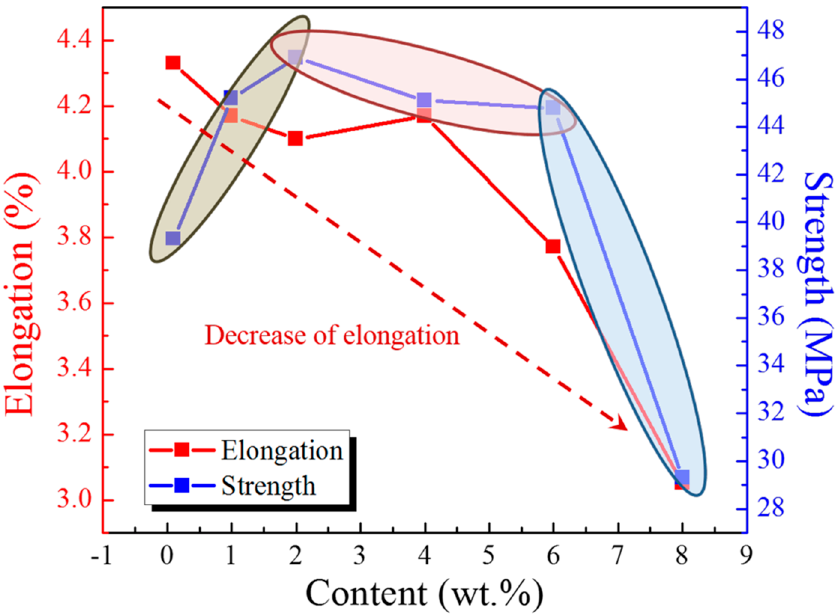
Figure 8. Tensile tests results (coating strength and elongation) of the coating with different content PANI-SSA.